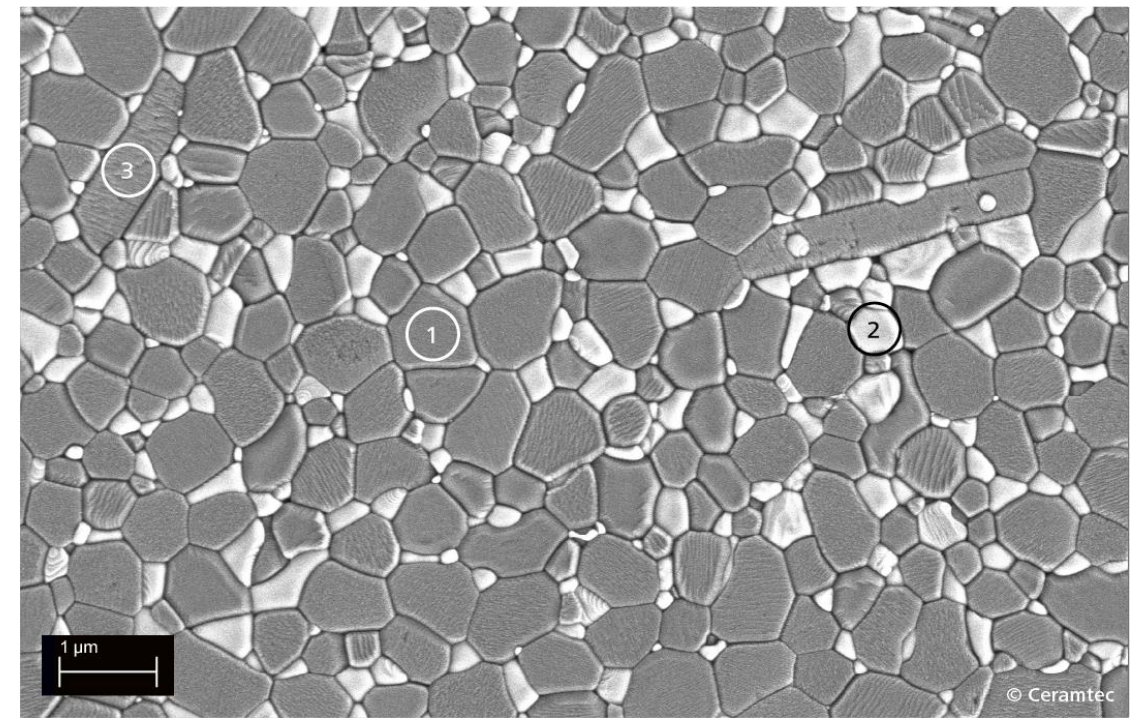
Figure 1. SEM image of the microstructure of the AMC composite ceramic BIOLOX ® delta (Courtesy CeramTec GmbH, Plochingen, Germany). The gray grains (1) are the alumina matrix, the white grains (2) are the zirconia phase, and the elongated grains (3) consist of reinforcing strontium hexaaluminate (SHA) platelets.